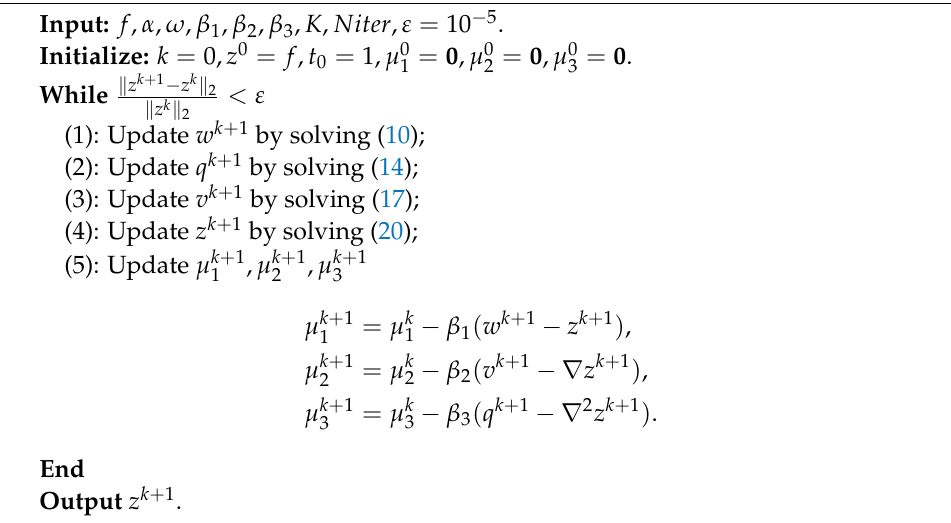
Algorithm 1: NHOGSHL for image restoration under multiplicative